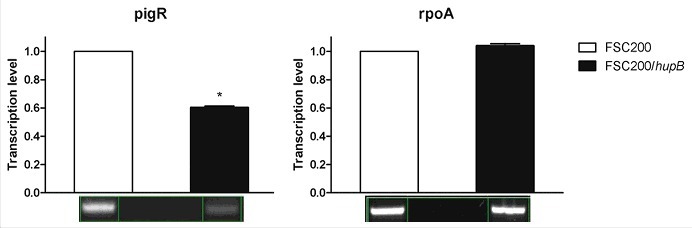
Semi-quantitative RT-PCR demonstrates decreased transcription level of pigR gene. Expression of pigR was verified on transcription level using reverse transcription followed by PCR. Samples were analyzed by gel electrophoresis and intensities of bands were determined by Bio1D software (CertainTech). pigR showed significantly decreased expression in mutant strain in contrast to WT, whereas the transcription level of rpoA remained unchanged. This result suggests HU participation in pigR regulation. P value < 0.05 *, P < 0.01 **, P < 0.001 ***, P < 0.0001 ****.